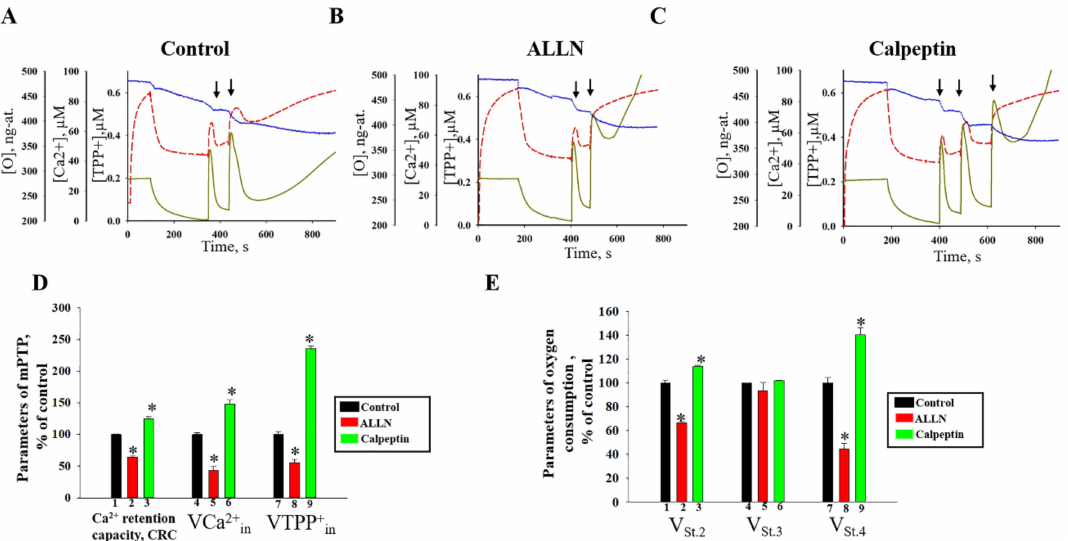
Figure 5. The effect of Calpain inhibitors, ALLN and Calpeptin on the Ca 2+ transport, membrane potential and respiratory rates parameters of RBM. ( A – C )—Alterations in Ca 2+ (green lines), TPP + (red lines) and O 2 fluxes (blue lines). The arrows indicate where CaCl 2 was added to the mitochondrial suspension. RBM were incubated in a standard medium, as described in the Materials and Methods. ( D , E )—Quantitative analysis of the action of ALLN and calpeptin on the Ca 2+ -induced mPTP opening; ( D )—quantitative analysis of the CRC (calcium retention capacity) and the rates of TPP + and Ca 2+ influxes (V TPP+ in and V Ca2+ in ); ( E )—quantitative analysis of the RBM respiration rate in states 2, 3, and 4. The values shown values are the means ± SD from three independent experiments; * p ≤ 0.05 compared with the value in the Control RBM without additions (control without additions was taken as